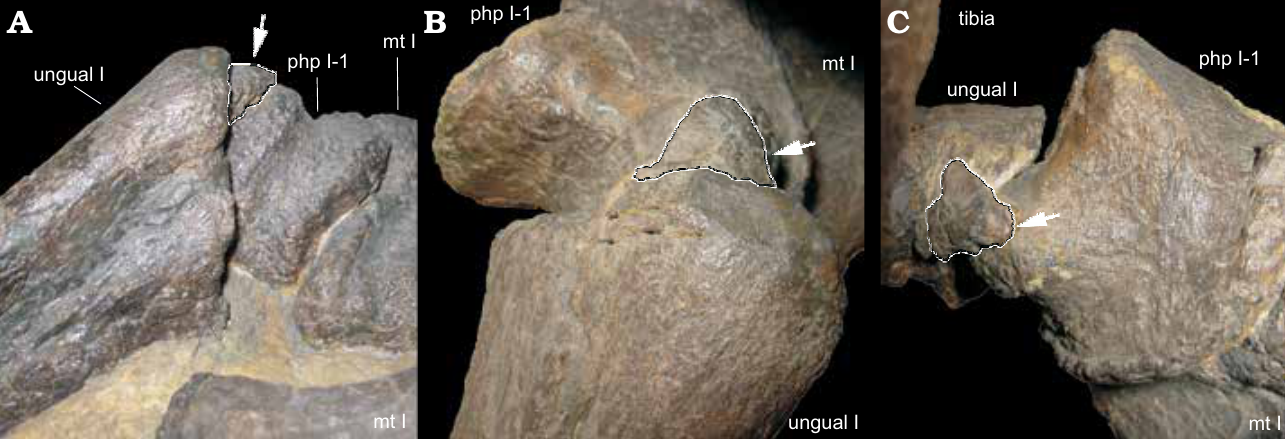
Fig. 2. Overgrowth type 1 (arrow) in left pedal ungual I of the camarasaurid sauropod SMA 0002 from Upper Jurassic Morrison Formation, Howe- Stephens Quarry, Wyoming, USA; in lateral ( A ), dorsal ( B ), and proximodorsal ( C ) views. Note the dorsal position of the overgrowth on the proximal articular surface, and how it fits in the notch in the distal articular surface of php I-1 (C, slightly displaced taphonomically). Abbreviations: mt, metatarsal; php, pedal phalanx. Not to scale, the proximodistal length of php I-1 is 45